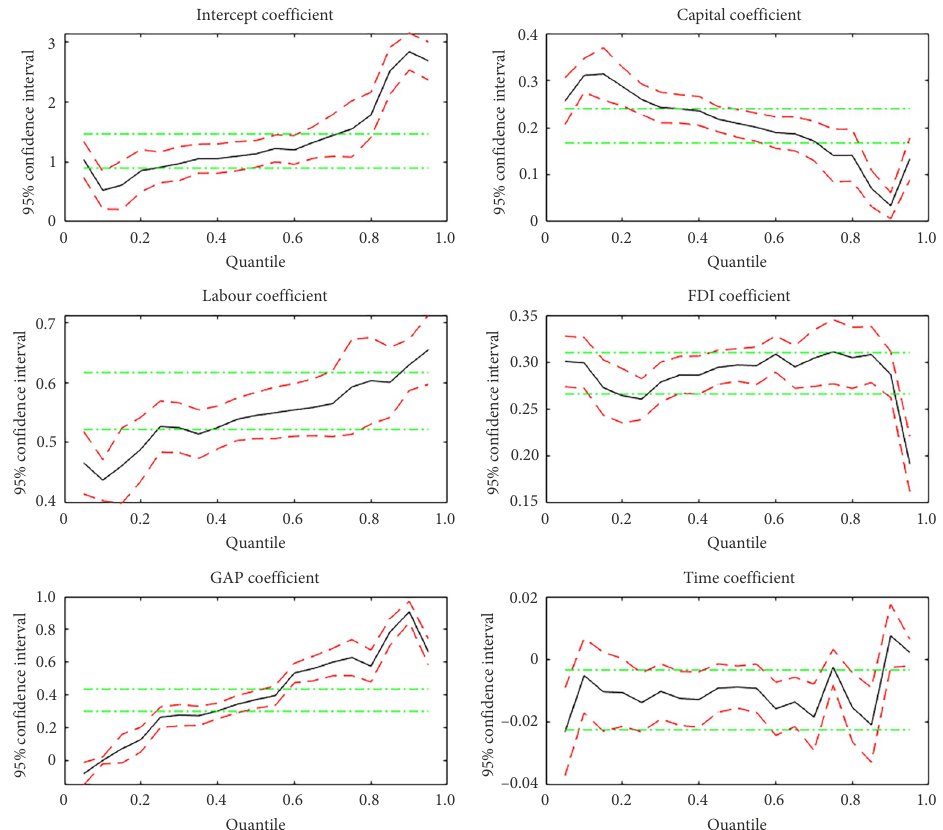
Figure 2. Quantile regression results for 0.5–095 quantiles; solid line: QR point estimate; dashed line: 95% confidence interval; horizontal dash-dotted line: 95% confidence intervals based on